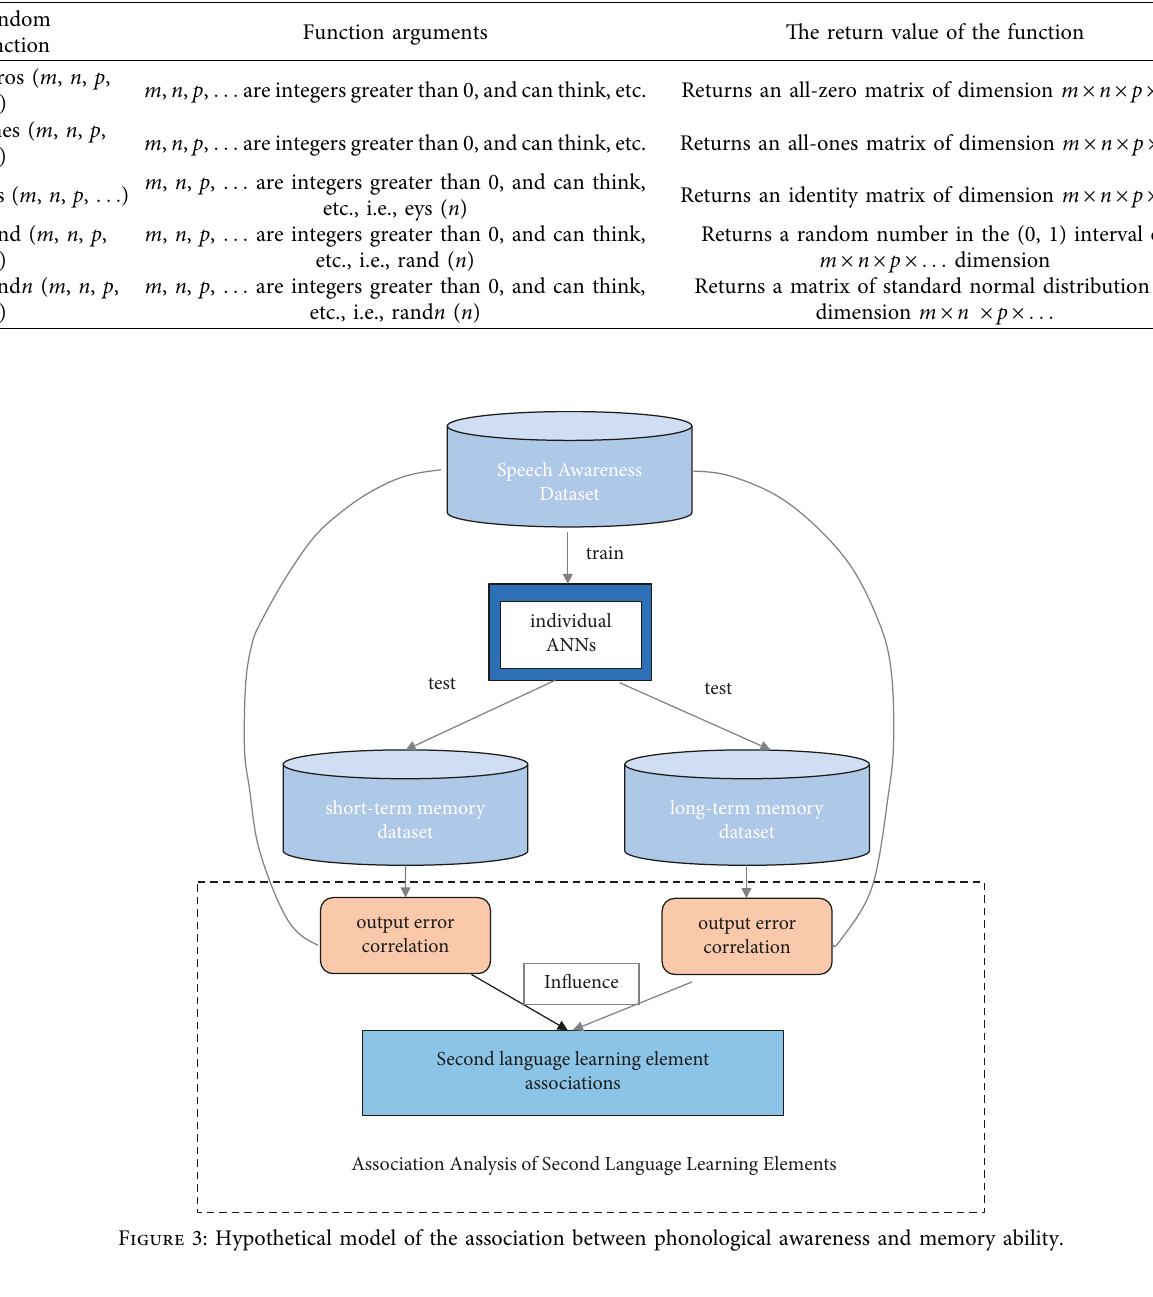
Table 1: Common random functions.